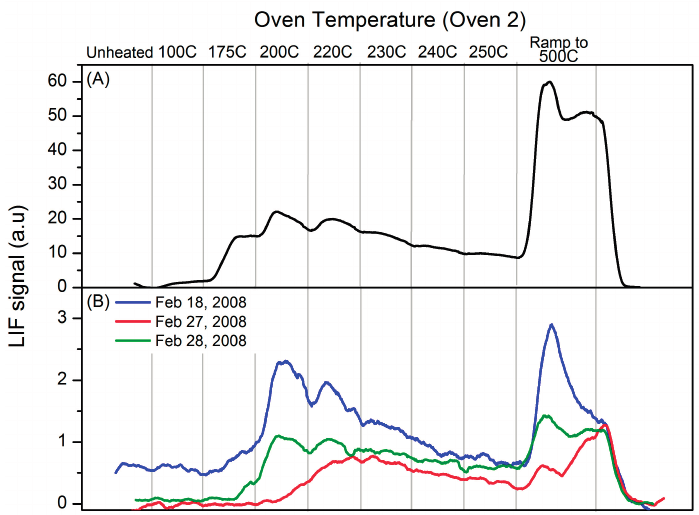
Figure 3. Panel ( A ). Calibration profile obtained using Oven 2 program for denuder loaded with pure HgCl ; Panel ( B ). Dissociation profiles obtained using Oven 2 program for stack 2 samples collected 18, 27 and 28 February